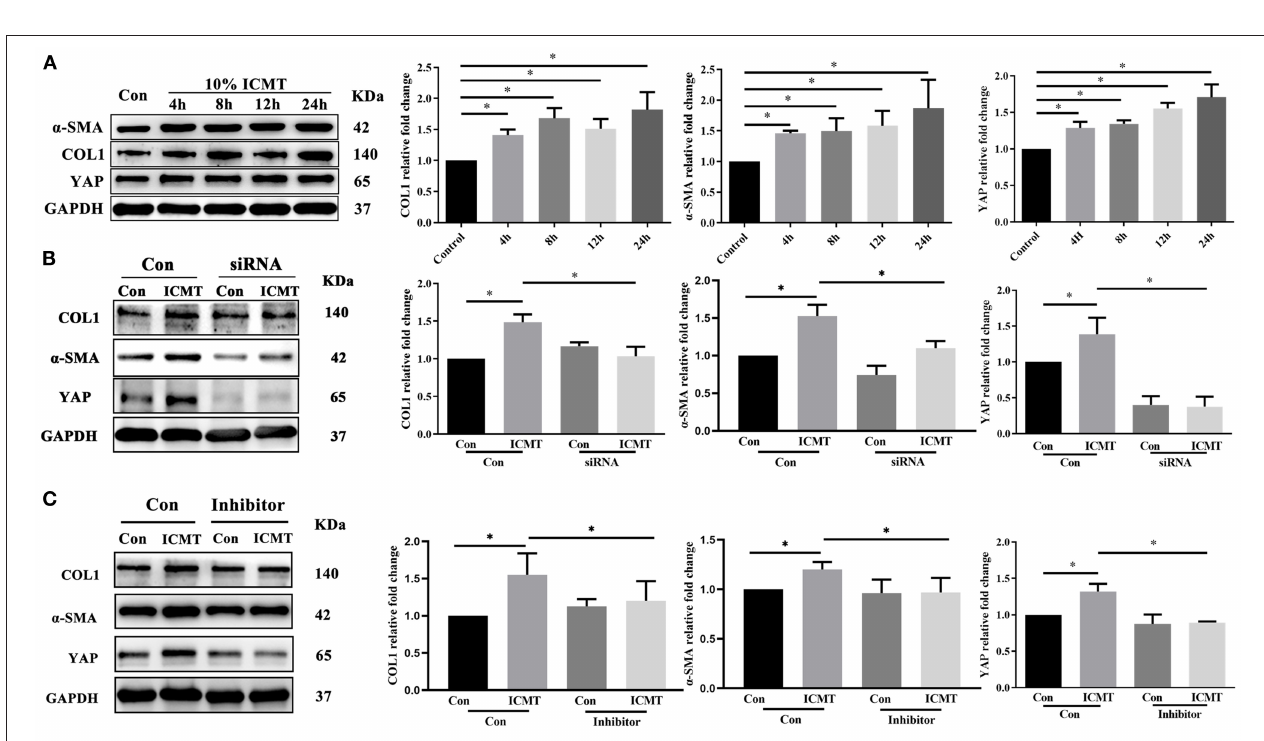
FIGURE 2 | immunofluorescence of YAP and α -SMA in the OHT model of SD rats. Scleral tissues were collected after the models were successfully established for 1 week. The results are presented as means ± SD ( n = 3), * P < 0.05. Abbreviations: OHT, ocular hypertension; SD, Sprague–Dawley; NT, normotension; COL1,